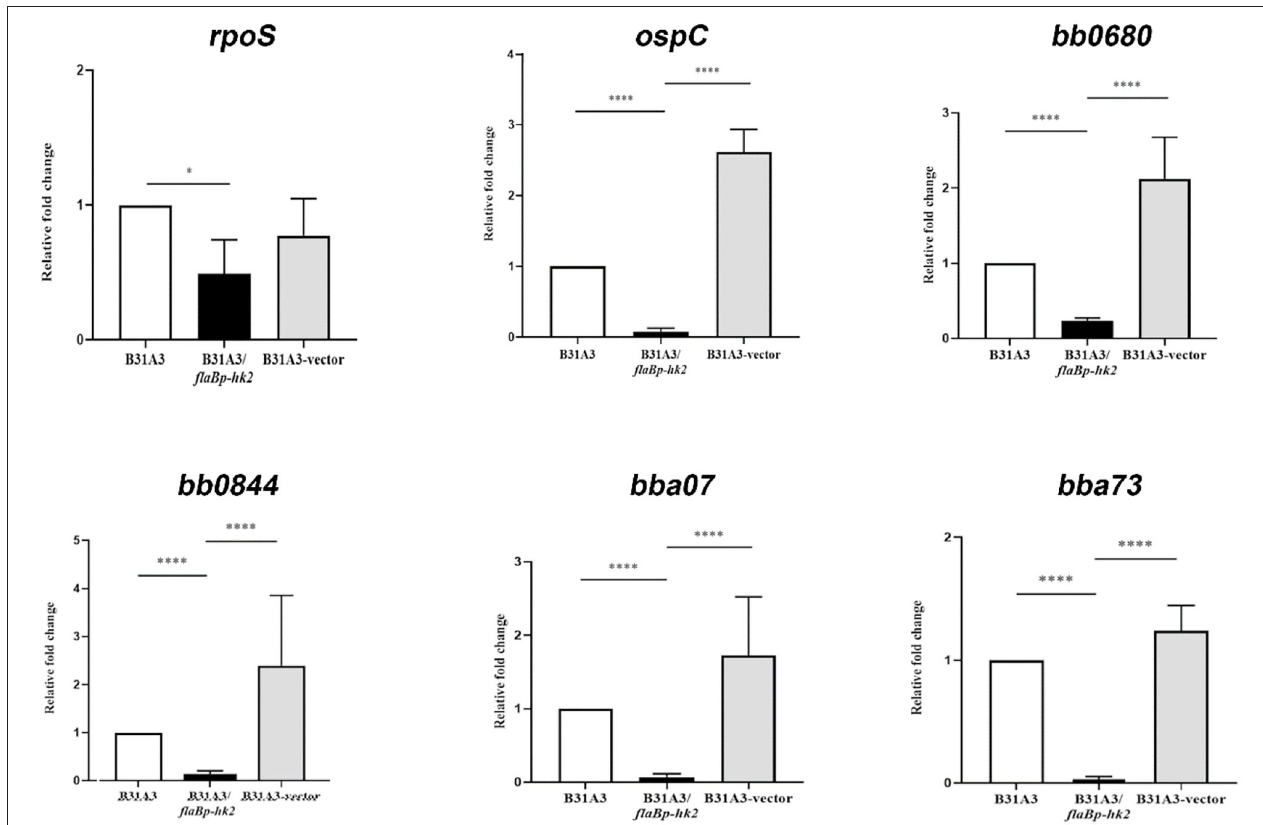
FIGURE 4 | qRT-PCR analyses of several RpoS-controlled genes. Spirochetes were cultured at 37 ◦ C in BSK-II medium and harvested in the late-log phase. RNAs were extracted and subjected to qRT-PCR analyses. Samples were first normalized with the flaB level, and then levels of gene expression were reported relative to that of wild-type B31A3 (with the level of expression of each gene in B31A3 as 1.0). * p < 0.01; **** p < 0.0001.